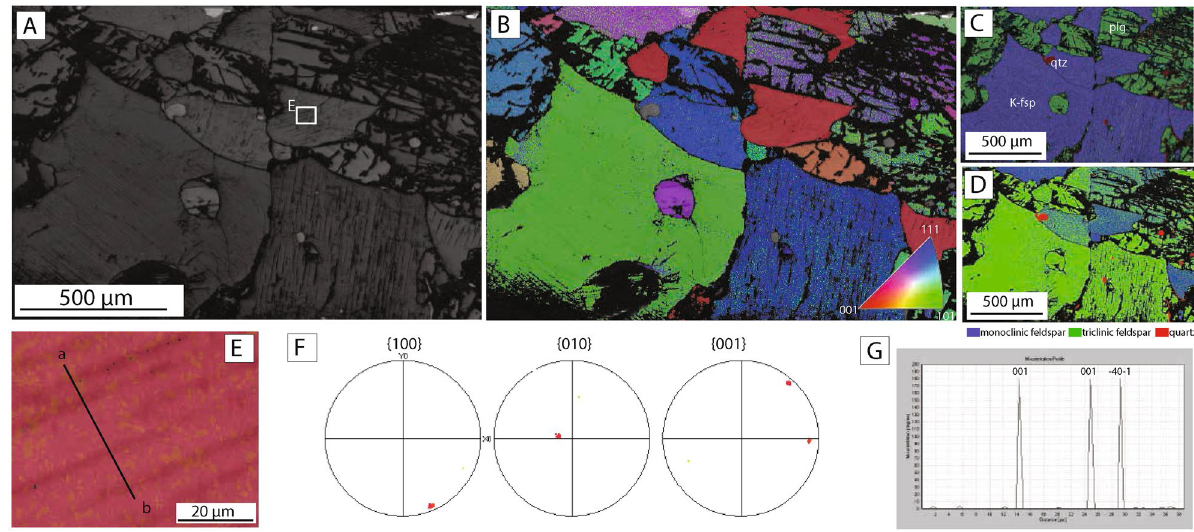
Figure 6. Crystallographic analysis of feldspar in the fracture-related fulgurite sample. (A) Band contrast image acquired during EBSD analysis. Note the presence of prominent planar features in the K-feldspar and the absence of internal structures in the plagioclase. (B) Crystallographic orientation map colored according to the inverse pole figure color code for feldspar (inset). (C) EDS chemical map. Quartz is shown in red, plagioclase is green, and K-feldspar is blue (D) EBSD phase map shows the distribution of mineral phases in the sample. Quartz is shown in red, triclinic feldspar (Plagioclase) as well as triclinic K-feldspar is green and monoclinic feldspar (K-feldspar) is blue. Note that some K-feldspar grains have monoclinic crystal symmetry while others have a triclinic one. (E–G) Crystallographic analysis of a monoclinic K-feldspar. (E) Orientation map overlapped on band contrast image. Black line shows the location of the misorientation profile shown in (G) . (F) Pole figure (upper hemisphere) shows the orientation of (100), (010) and (001) axis of the K-feldspar crystal. (G) Misorientation profile across the examined grains shows the rotation angle and rotation